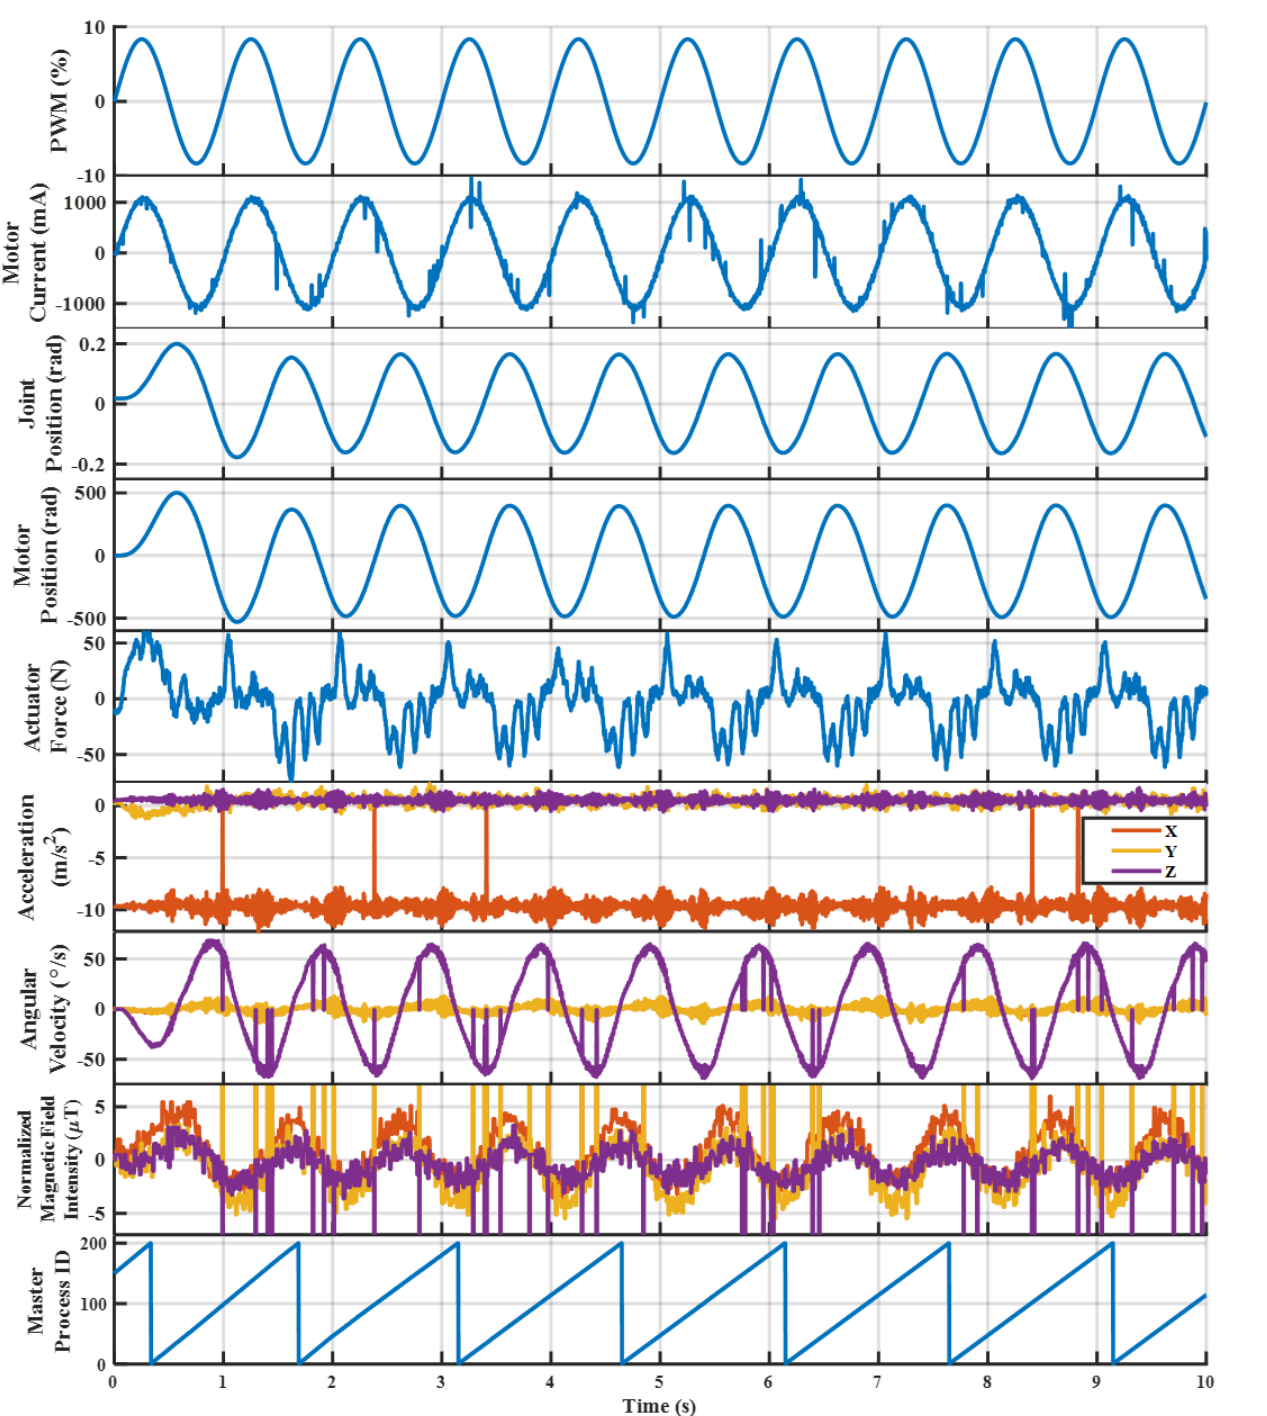
Figure 14. Hardware performance for an open − loop 1 Hz, 1000 mA amplitude sinusoidal input on the pendulum test